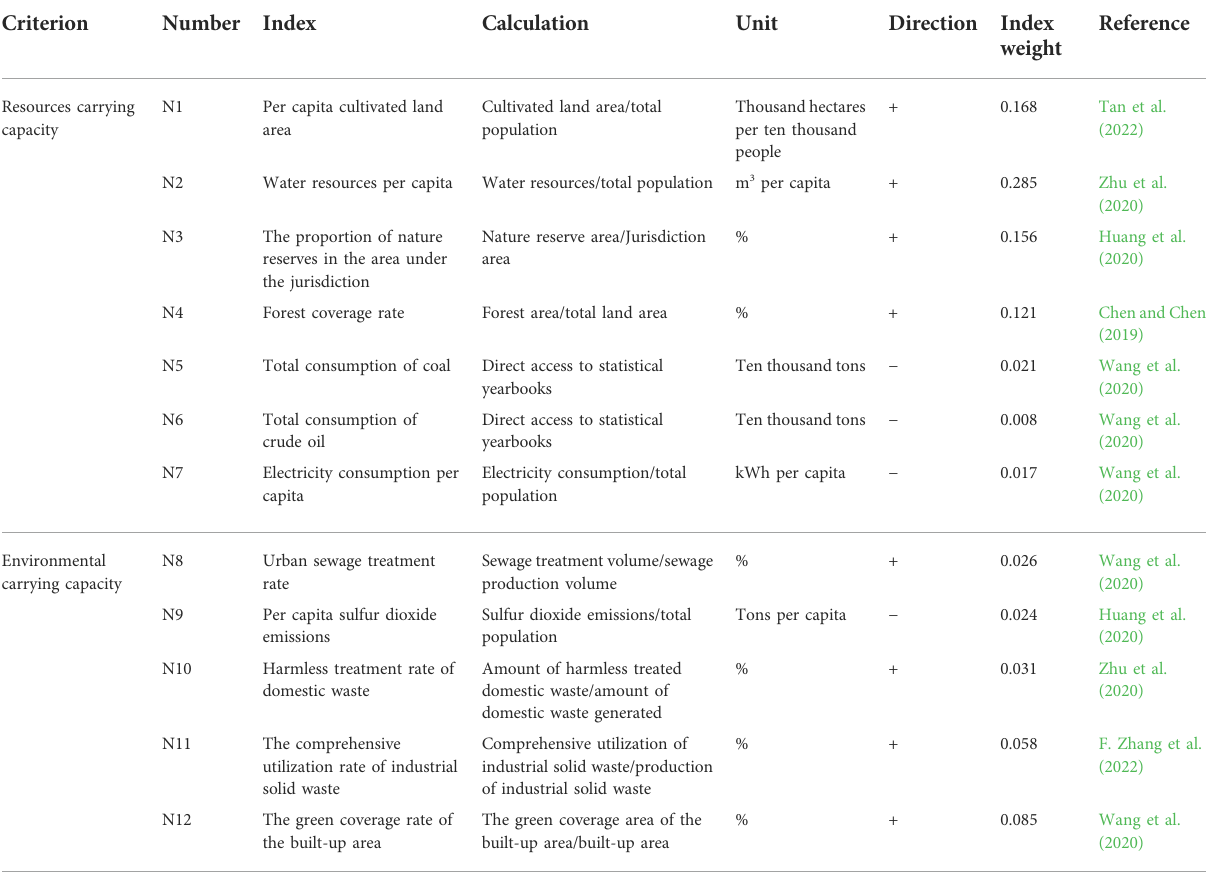
TABLE 1 The index system of resource and environmental carrying capacity